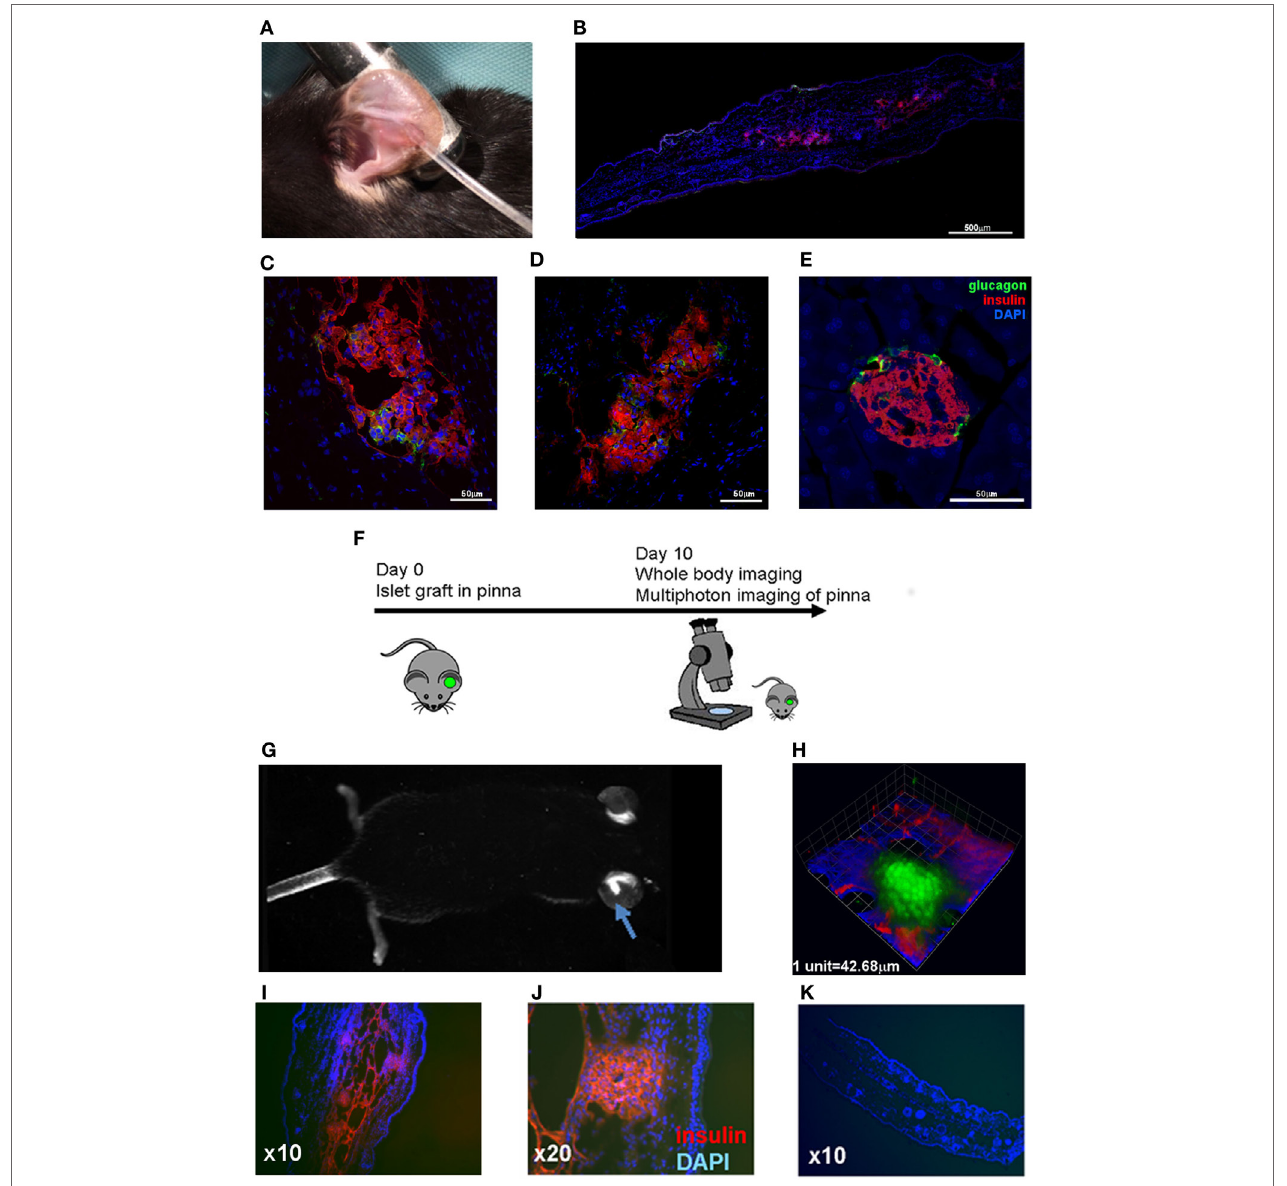
FigUre 1 | Pancreatic islets grafted into the pinna of the ear retain capacity to produce insulin and can be used for non-invasive imaging. (a) C57BL/6 islets were grafted into the pinna of syngeneic C57BL/6 recipients. (B) 12 weeks later, islets were readily detected in the pinna, and higher magnification revealed glucagon positive cells (green) among the insulin positive beta cells (red) (c,D) . The same staining was performed on islets in the pancreas of the graft recipient (e) . (F) Islets isolated from a Kaede transgenic mice were grafted into the pinna of syngeneic C57BL/6 mice. On day 10, the graft recipient was anaesthetized and analyzed with whole body imaging and multiphoton microscopy. (g) On day 10, green fluorescent islets could be detected in the pinna using whole body imaging. An arrow indicates the fluorescent mass in the grafted ear. (h) The green fluorescent grafted islets could also be detected with multiphoton imaging (3D rendering of a Z-stack capture). (i,J) The graft bearing pinnae were fixed and stained to check for insulin production (red), and compared with a cross section of a control pinna (K) . The selected images are representative of results from groups containing at least three